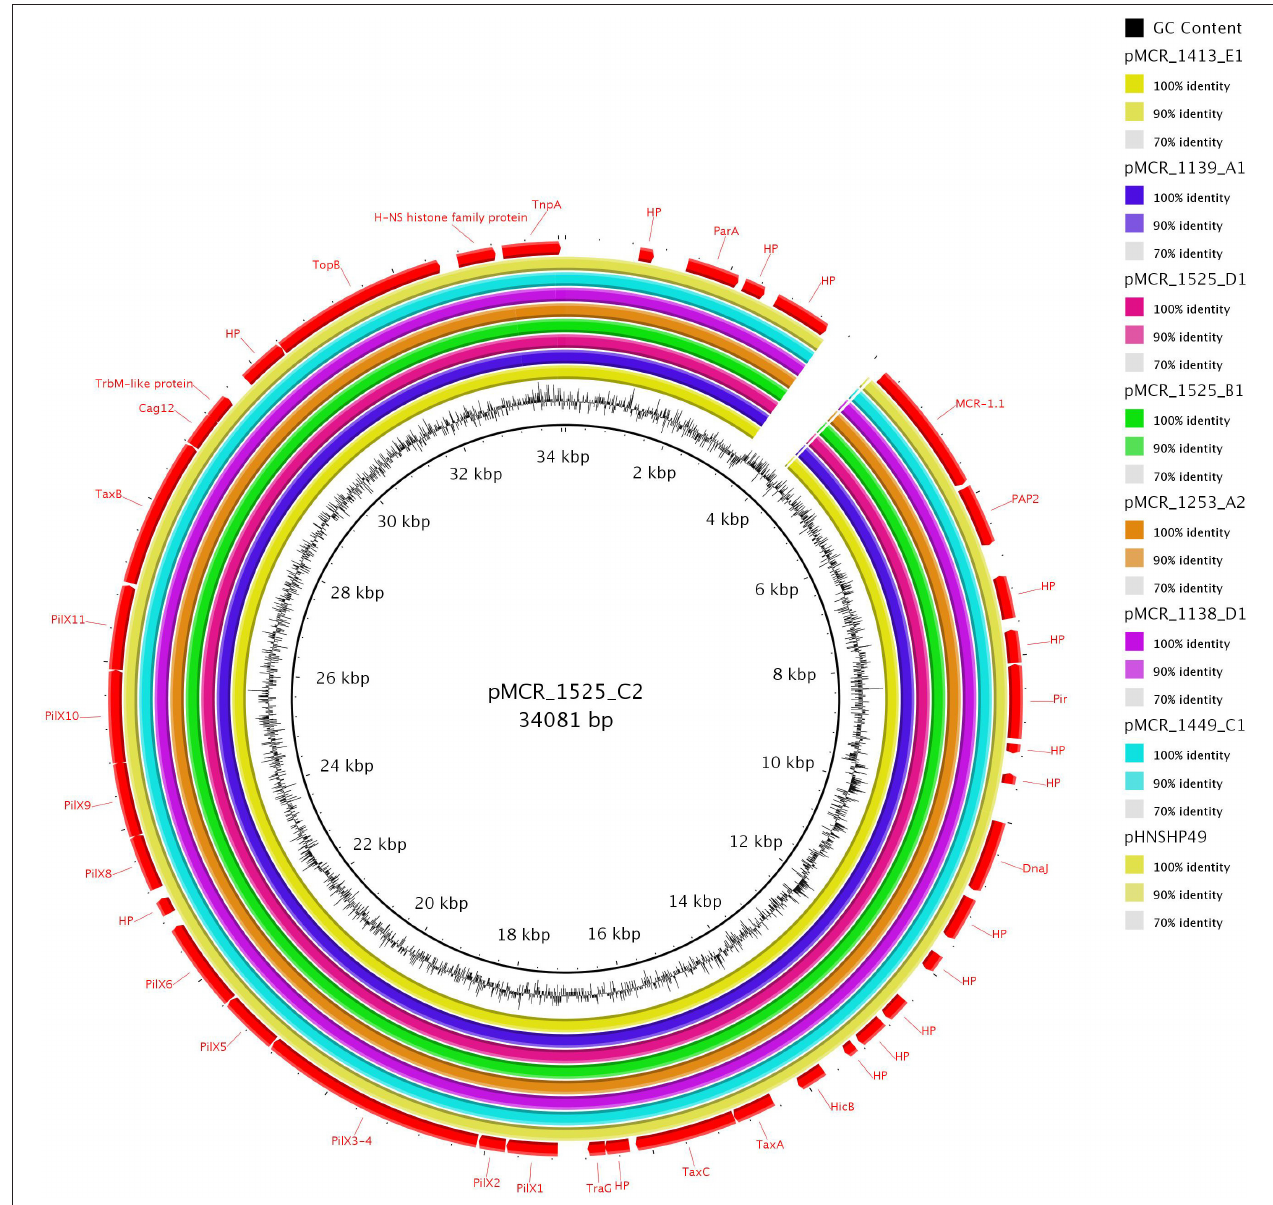
FIGURE 1 | Sequence alignment of eight IncX4 and one hybrid IncX4-I2 mcr-1 -encoding plasmids. The plasmid pMCR_1525_C2 (GenBank accession no. MT929281) was used as a reference for the comparison.